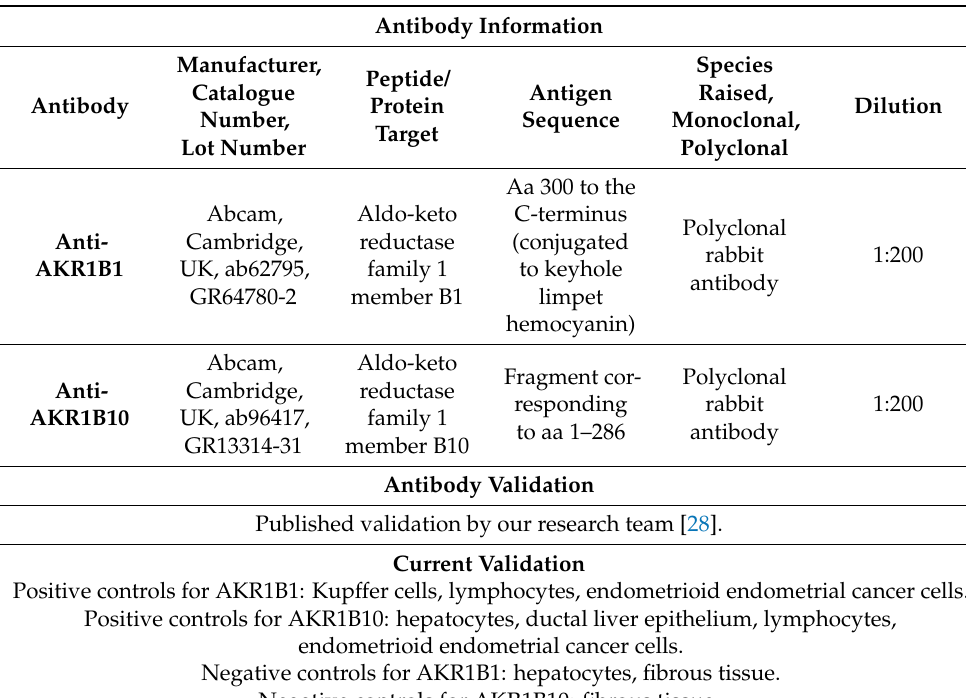
Table 2. Antibody description and validation.